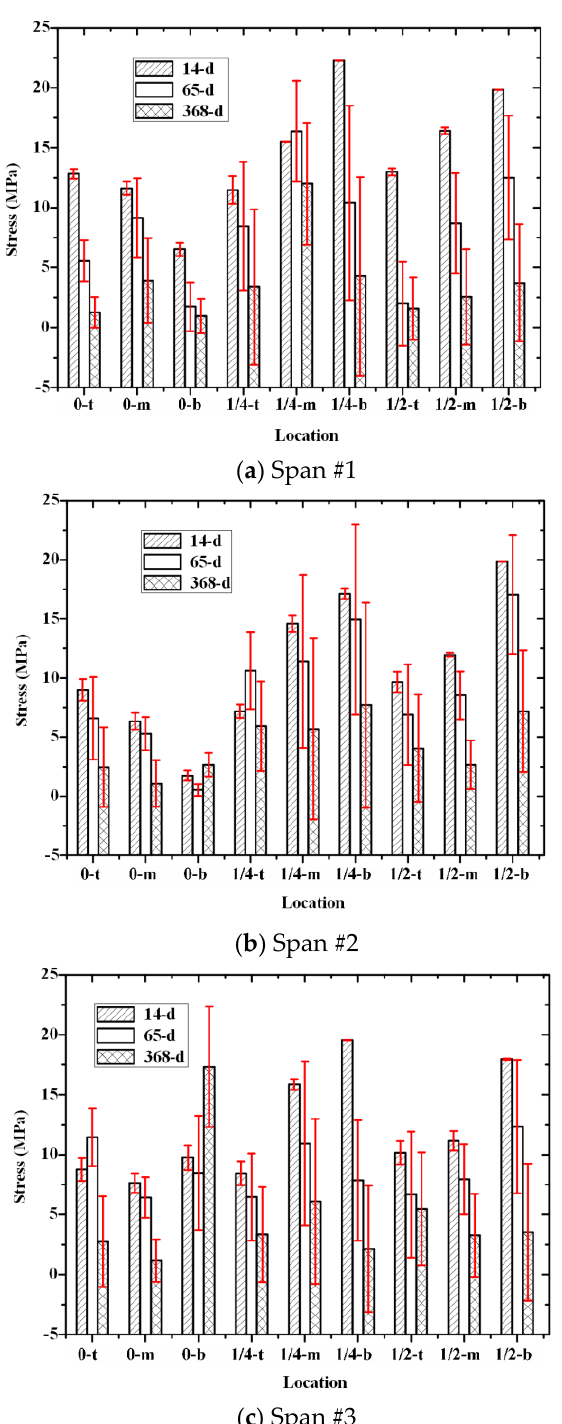
Figure 6. Posterior distributions of the stress based on the linear simplified analysis. The monitoring point at the top flange of the 1/4 span cross-section of Span # 2 was selected as an example. The joint probability density distributions of the stress at 65 days and 368 days are shown in Figure 7. In the figure, the horizontal and vertical axes represent the stress of concrete at 65 days and 368 days, respectively. The shadow in the figure represents the probability of the stresses. It can be seen from the figure that there are some stress series relative to the monitored strain in the model space. The mean value and